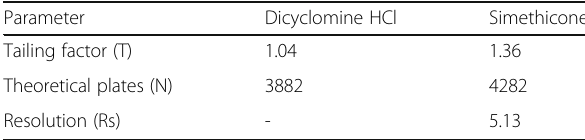
Table 1 System suitability